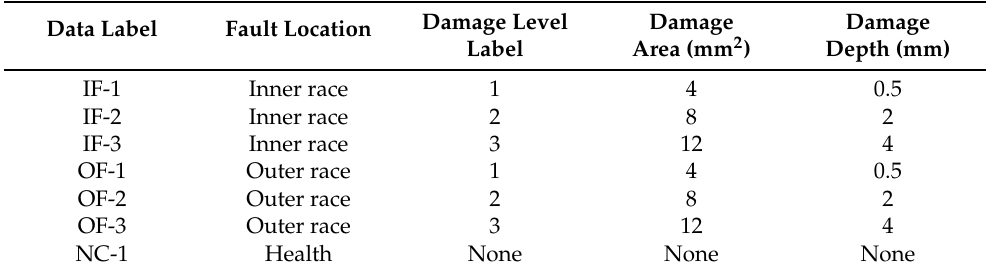
Figure 5. ( a ) SQV dataset acquisition test bench. ( b ) Fault simulation bearings. Table 3. Division of SQV dataset.